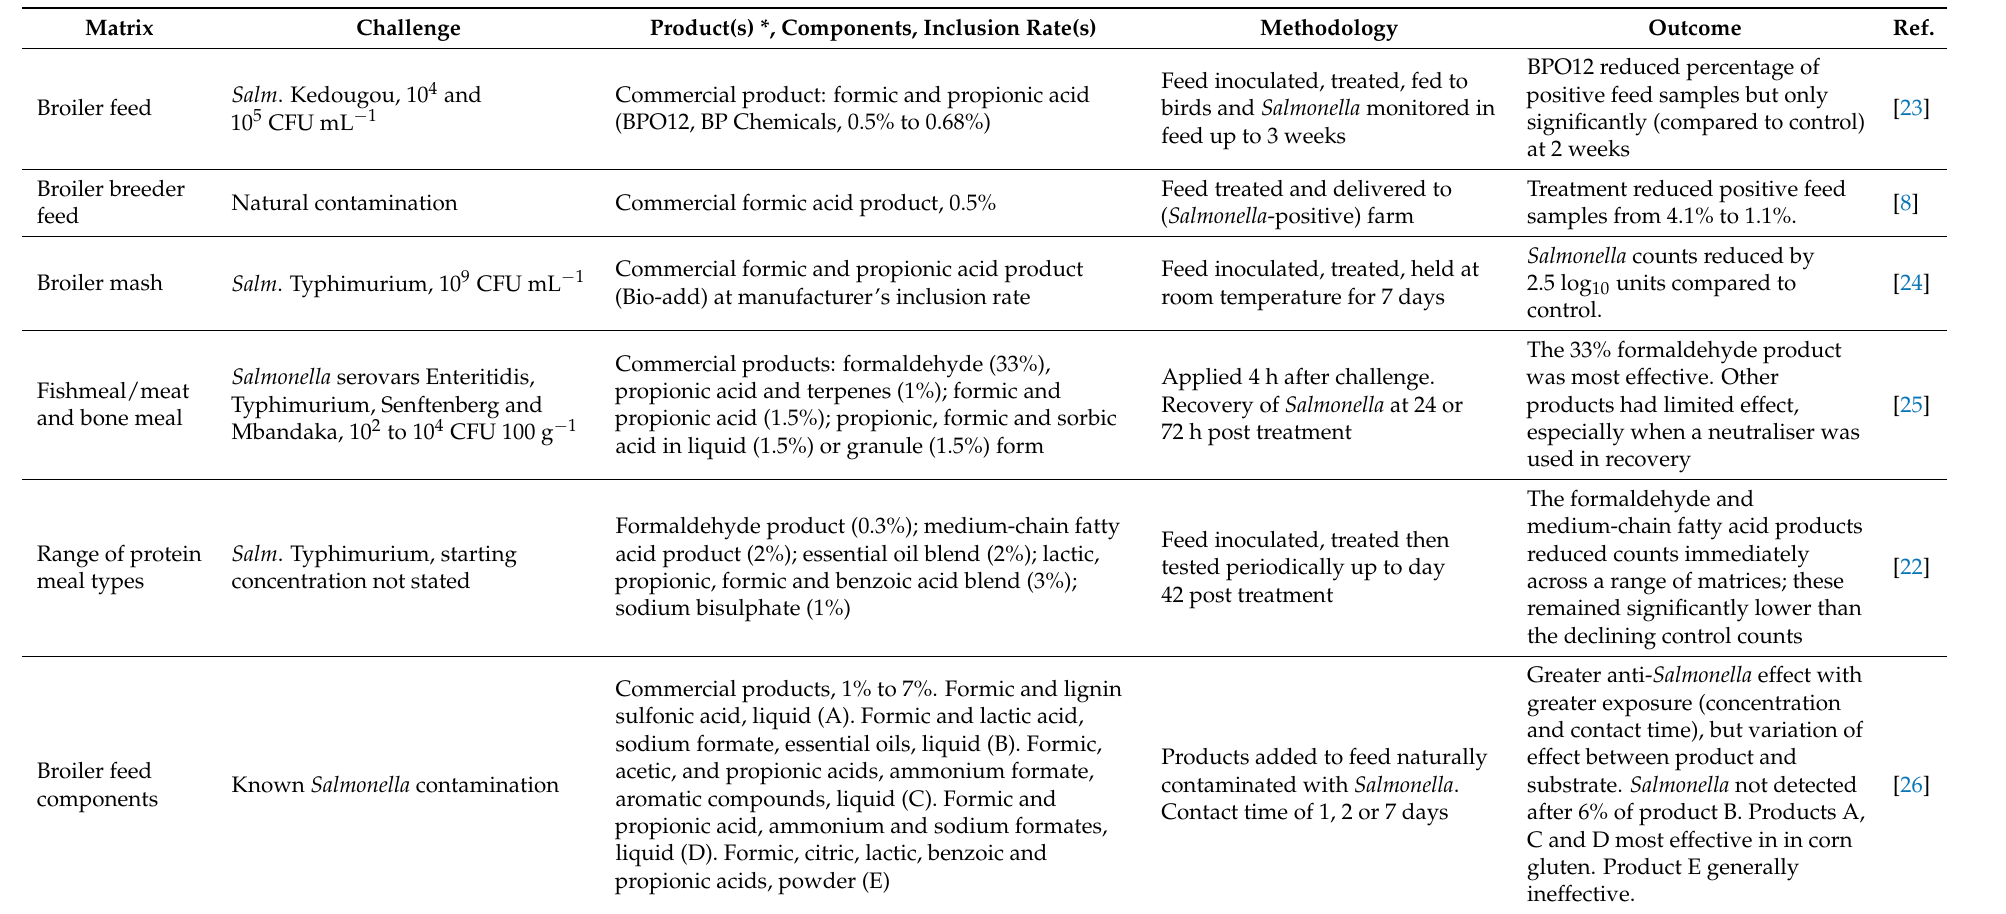
Table 1. Studies on the use of microbicidal additives to reduce Salmonella contamination in animal